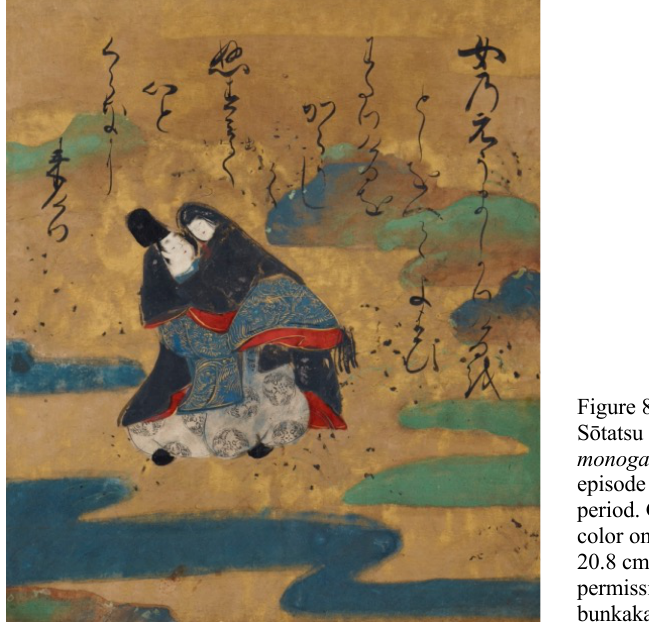
Figure 8. Tawaraya Sōtatsu (attrib.). Ise monogatari album leaf, episode 6. Early Edo period. Gold, ink, and color on paper. 24.6 x 20.8 cm. By permission of Yamato